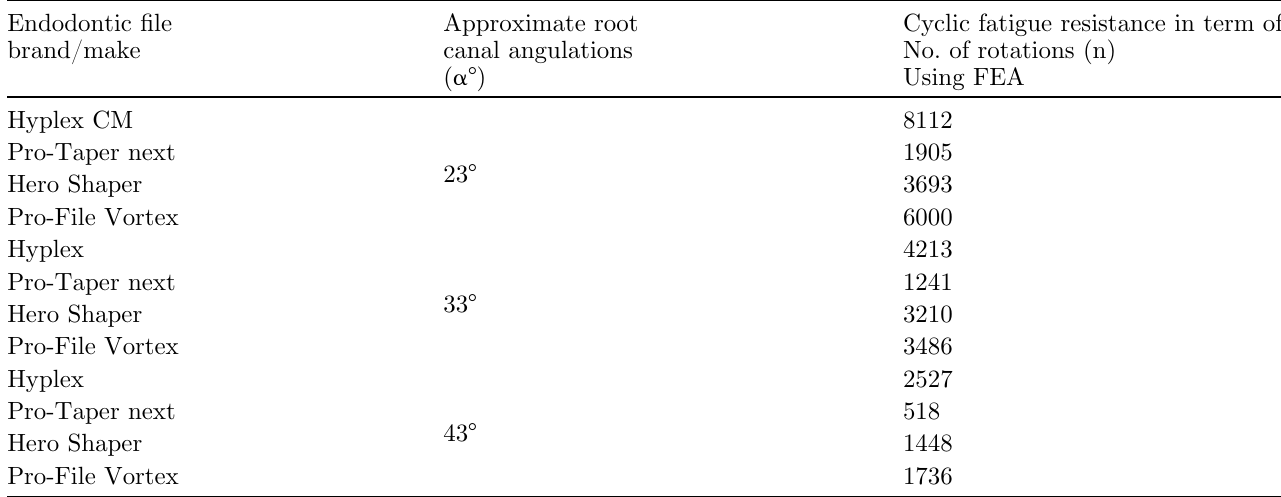
Fig. 7. Fatigue life for hyplex CM endodontic fi le (isometric view). Table 4. Effect of rotary motion on fatigue life of endodontic fi